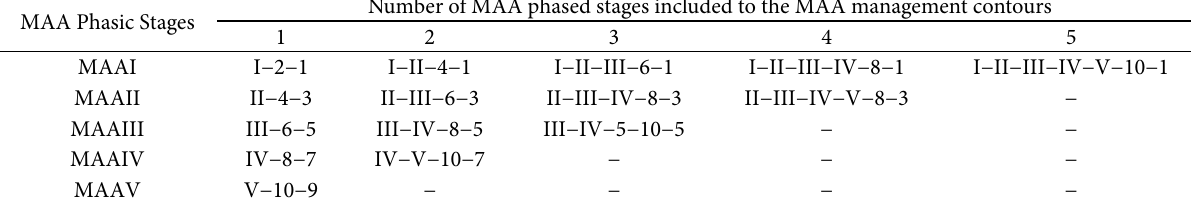
Table 1 . M anagement